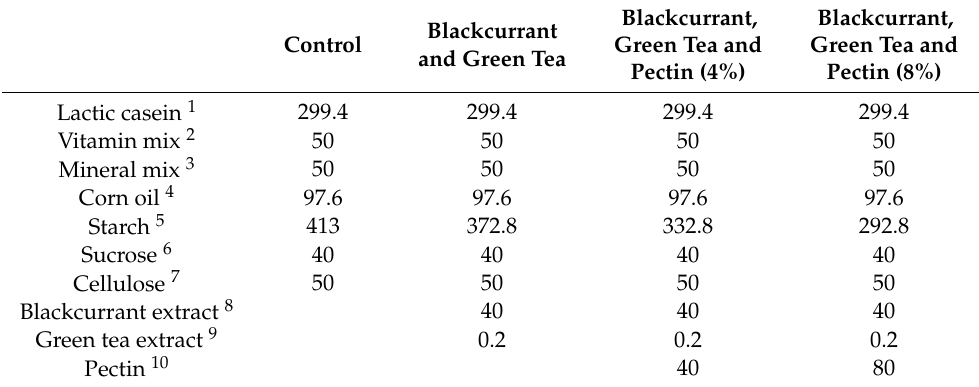
Table 1. Ingredient compositions of experimental diets